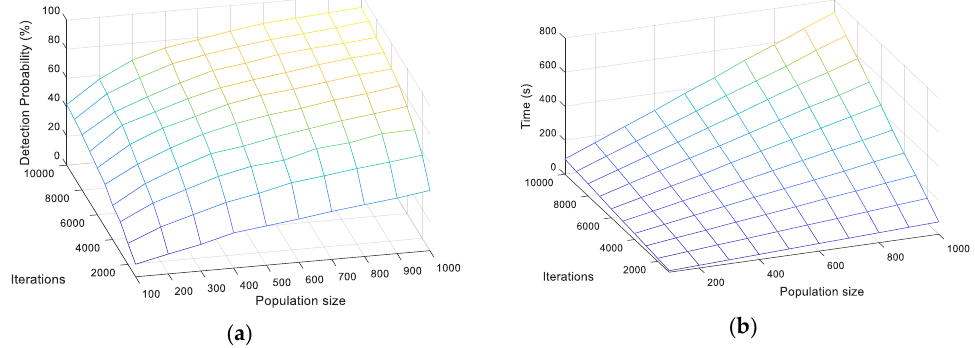
Figure 10. The relation of the performance and computational cost with different iterations and population size—( a ) detection probability and ( b ) computational cost.